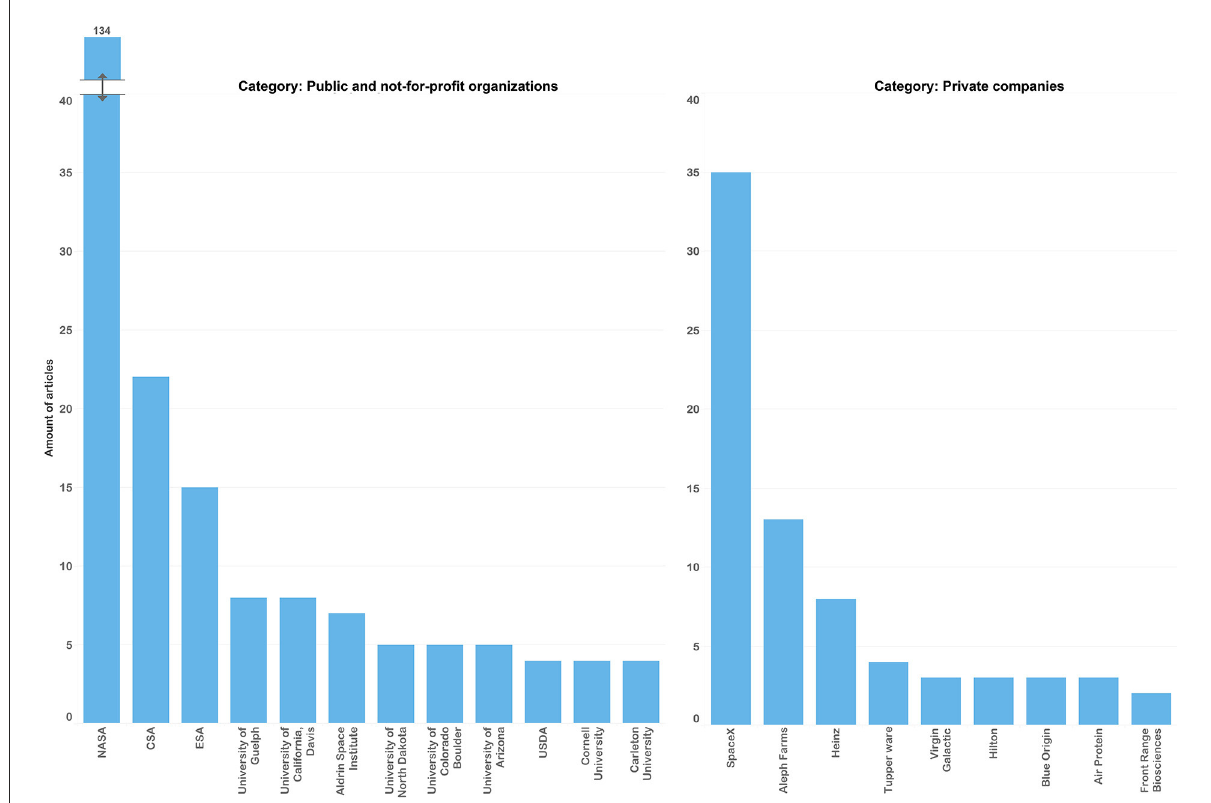
FIGURE4 Public and private organizations mentioned. Bar chart showing proportion of articles in the word frequency analysis referencing a specific organization, separated by public/not-for-profit and private companies. Chart has been scaled down to better show variance in organizations with fewer references than NASA, which was referenced 3.8 × more often than the second most-mentioned